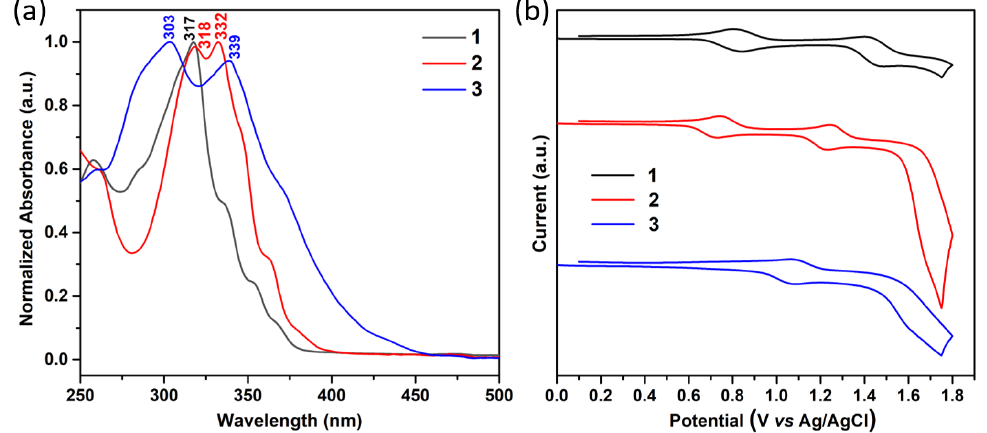
Figure 2. ( a ) Normalized absorption UV-vis spectra of 1 – 3 in CH 2 Cl 2 at c = 5 × 10 −6 molL −1 ; ( b ) cyclic voltammograms of 1 – 3 at c = 10 −5 mol L −1 recorded in CH 2 Cl 2 /0.1 M TBAH using a Pt working elec- trode.